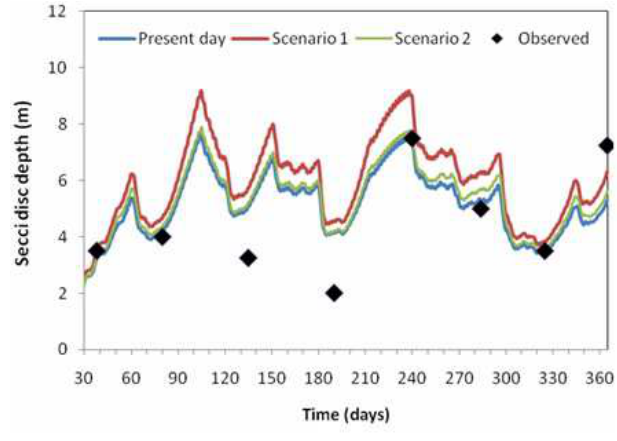
Fig. 10. Time evolution of simulated SDD in response to present-day nitrogen loads and two scenarios involving separately reduced domestic (scenario 1) and river (scenario 2) loads. Observed SDD values are marked by diamond